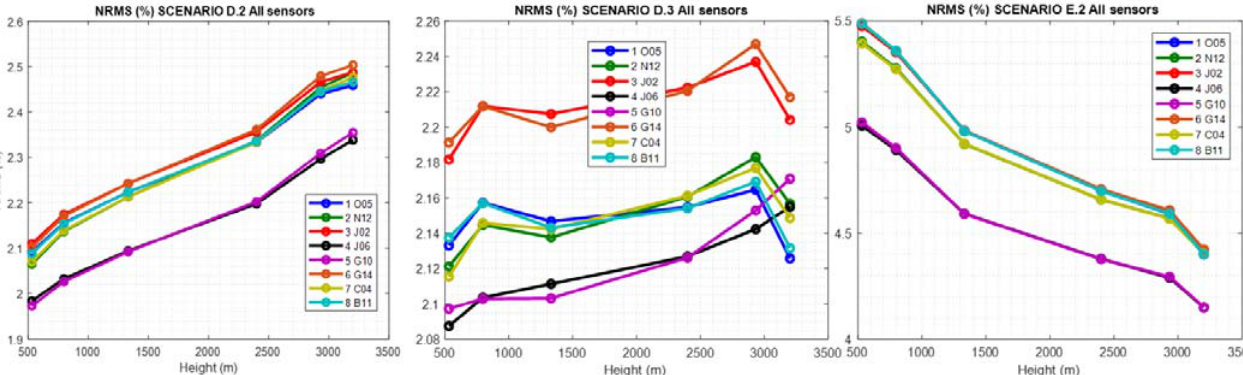
Figure 6: From left to right; Axial NRMS distribution of all sensors for the scenarios D.2 (±3 %, ±1 ºC, random vib. 1mm), D.3 (±2 %, ±1 o C, 1.5 Hz 1mm) and E.2 (±1 %, ±3 o C, random vib.